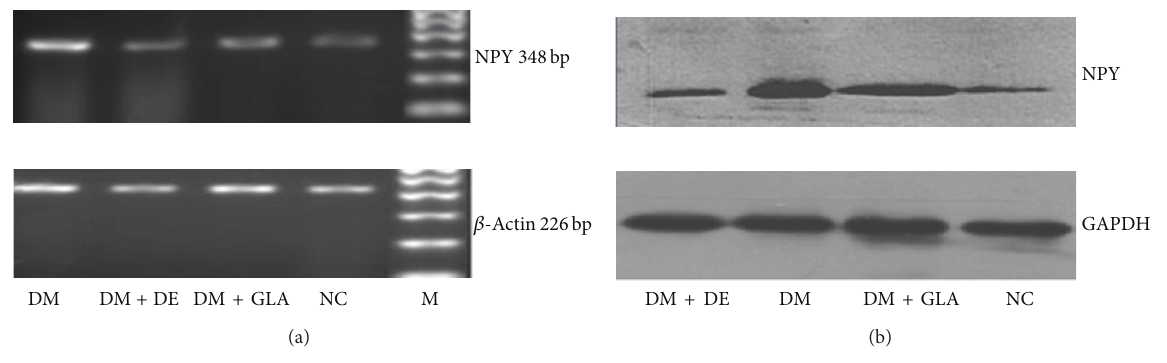
Figure 1: (a) PCR electrophoretogram of NPY mRNA and 𝛽 -actin, (b) the expression of NPY protein and GAPDH. (Note: DM for Diabetes group, DM + DE for detemir-treated diabetes group, DM + GLA for glargine-treated diabetes group, NC for normal control group, and M for marker).